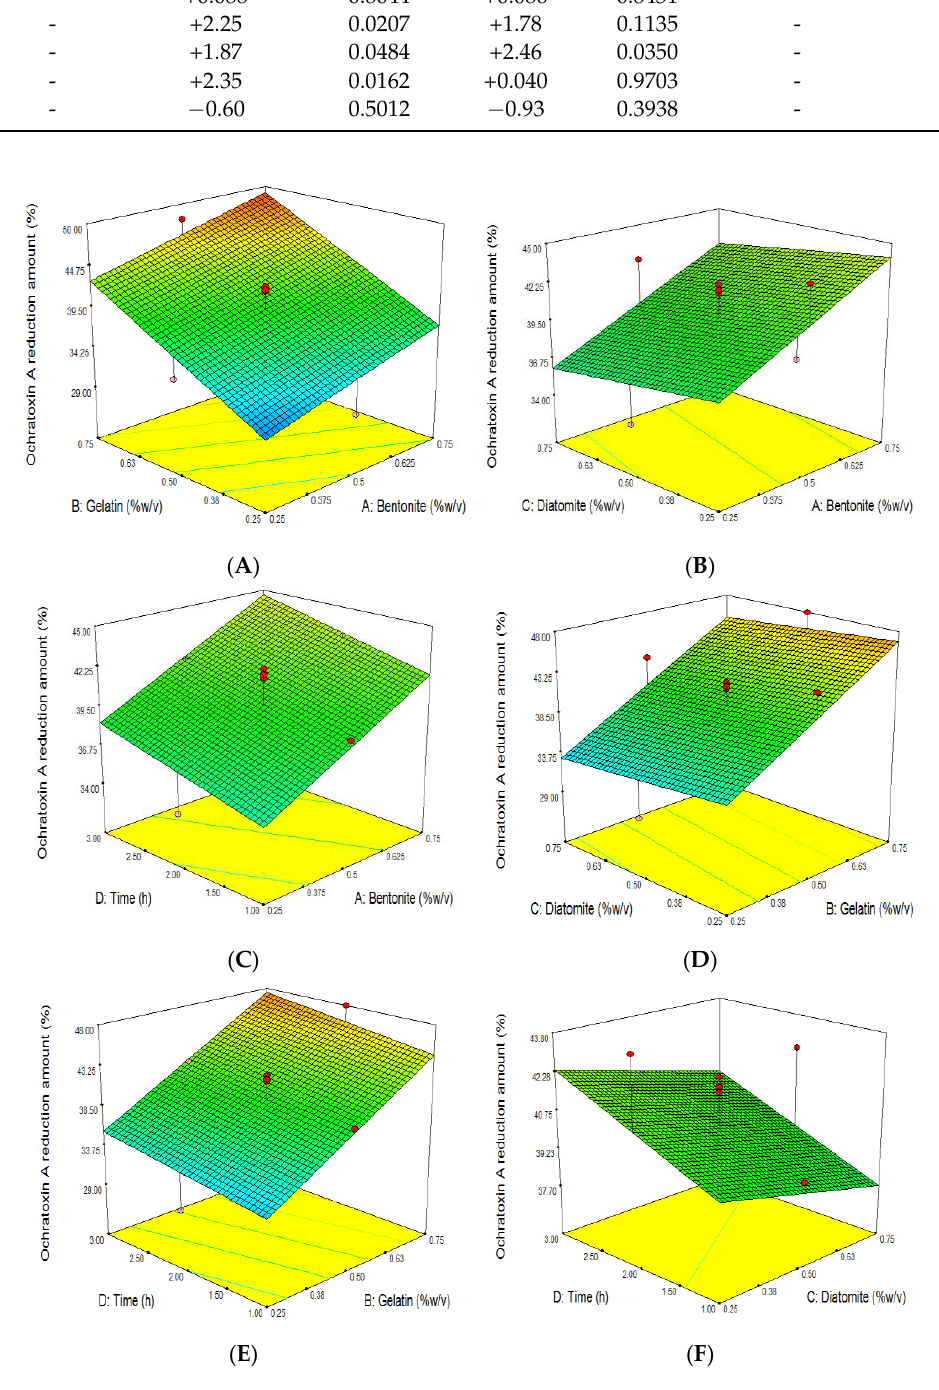
Figure 1. Response surface plot of the effects of bentonite, gelatin, and diatomite concentration